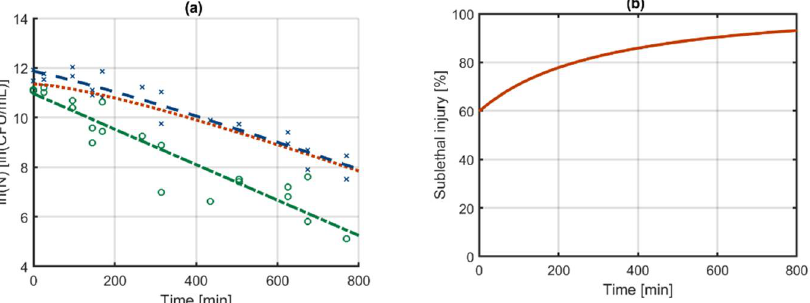
Figure 3. ( a ) Log-linear inactivation of all culturable (—) and healthy culturable (- · -) cells as described by the independent models or sublethal injury model that is constructed with the model of Bigelow and Esty [49]. Based on these modelling results, the evolution of the data are sublethally injured population (···) and ( b ) the percentage sublethal injury ( — ) is calculated. The based on counts of culturable ( x ) and healthy ( o ) cells on non-selective and selective media as published in Smet et al. [42]. The dataset was constructed by monitoring the survival of Salmonella Typhimurium, which was grown as planktonic cells in an environment at pH 5.5 with 60 g/L NaCl, after being treated in a liquid carrier with cold atmospheric plasma and stored at 8 °C (Dataset 1).